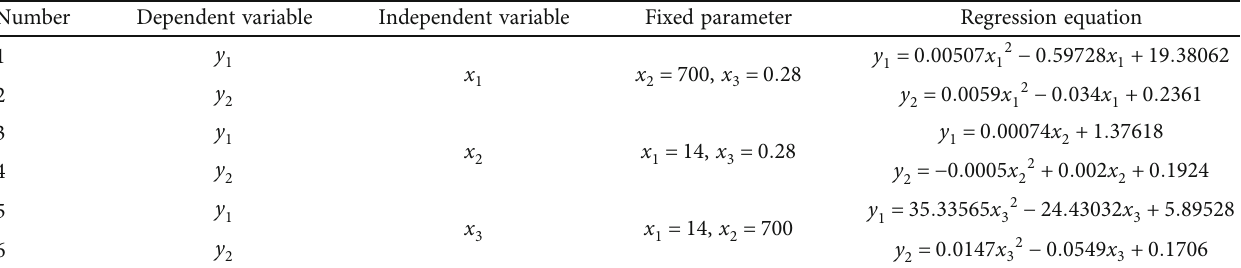
Figure 13: Displacement changes of retaining wall under di ff erent replacement thicknesses of lightweight foamed concrete. Table 6: Regression equations with di ff erent factors.